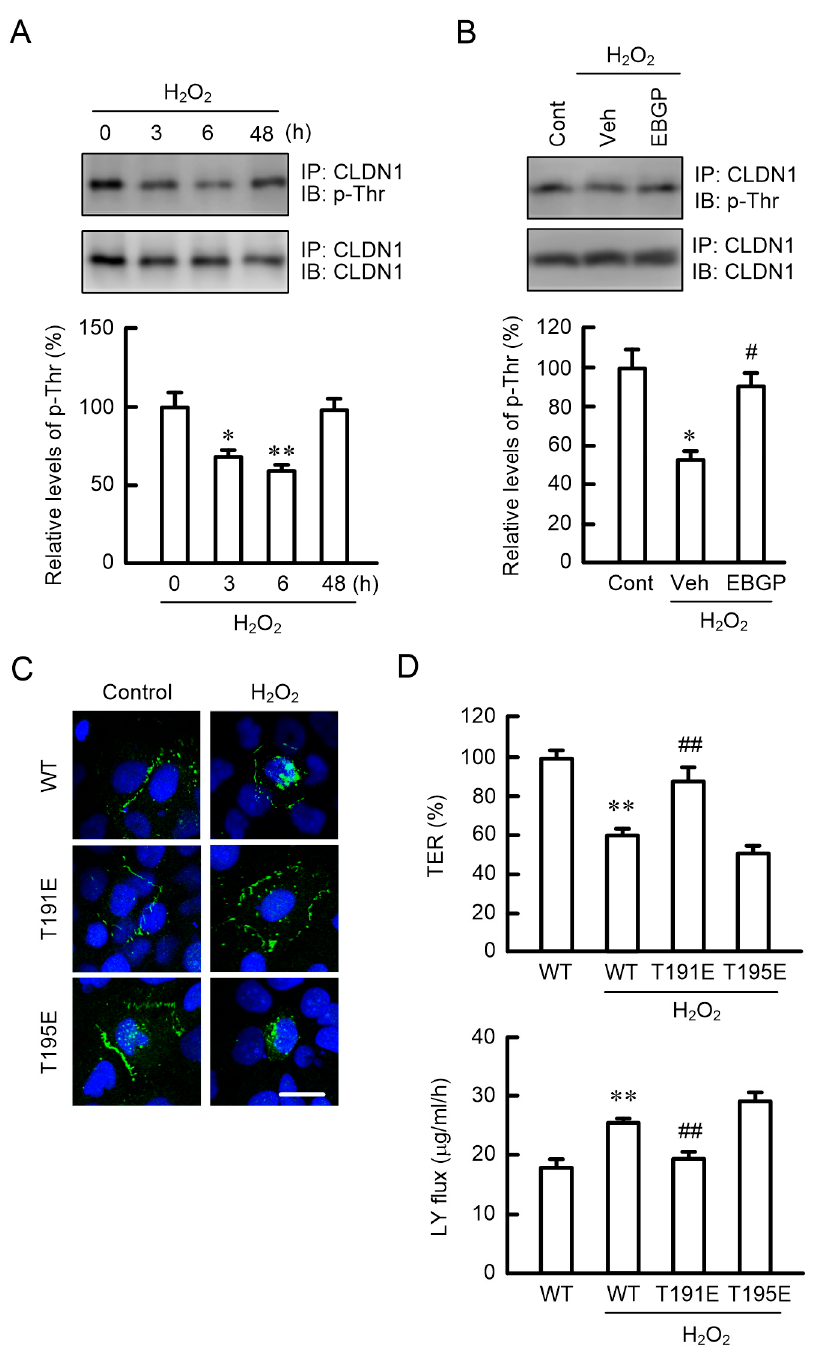
Figure 6. Effects of phosphorylation mimic mutants on H 2 O 2 -induced barrier destruction. ( A ) Cell lysates were prepared from the cells exposed to 200 µ M H 2 O 2 for the periods indicated. ( B ) Cell lysates